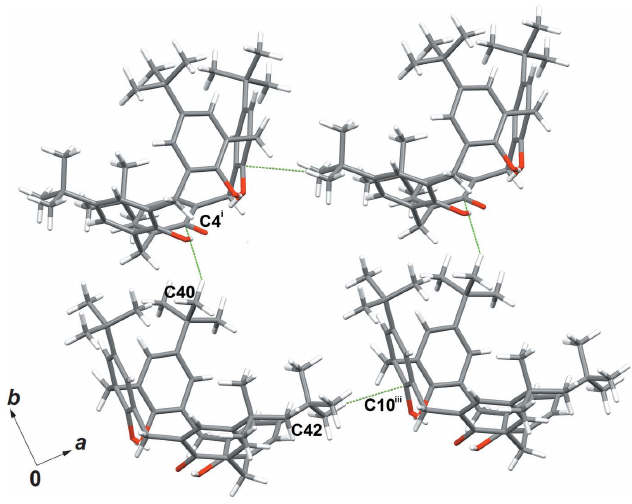
(cid:3) x , 1 (cid:3) z ; (iii) 1 + x , y , z .] + y , 3 2 2 2